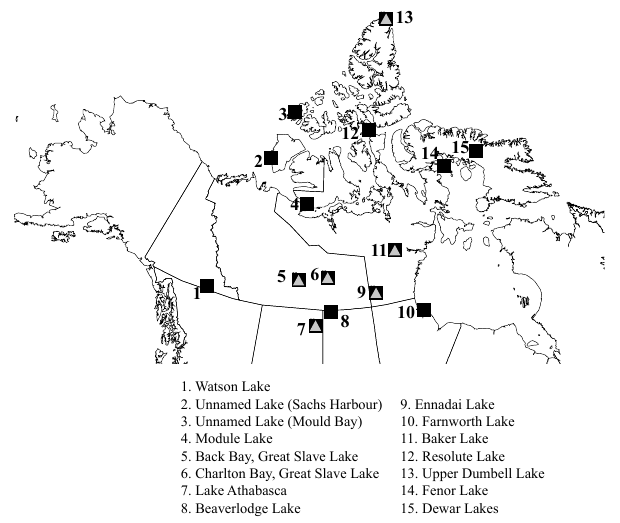
Fig. 3. Lakes used as validation sites for the model simulations. Squares represent the lakes used for ice phenology validation, trian- gles represent the lakes where snow depth on ice and ice thickness data was also